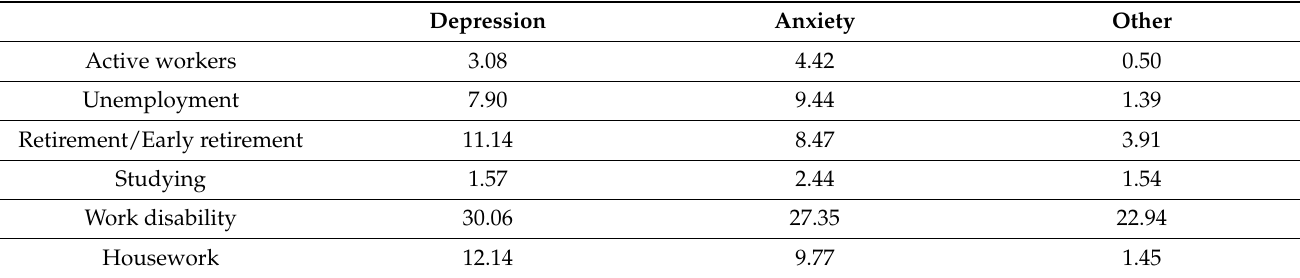
Table 1. Prevalence (%) of mental health issues related to economic activity. Source: Encuesta Nacional de Salud en España (ENSE) 2017